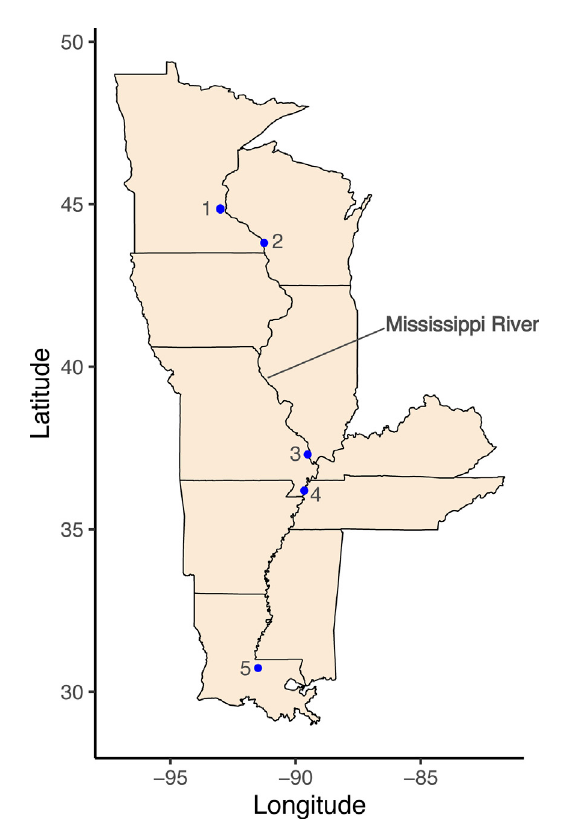
FIGURE 1 Map of the mainstem Mississippi River and the surrounding U.S. states. Fish sampling locations are represented by blue dots and numbers that correspond to descriptions in Table 1. The inset map in the bottom right shows the 48 contiguous U.S. states and the mainstem Mississippi River in